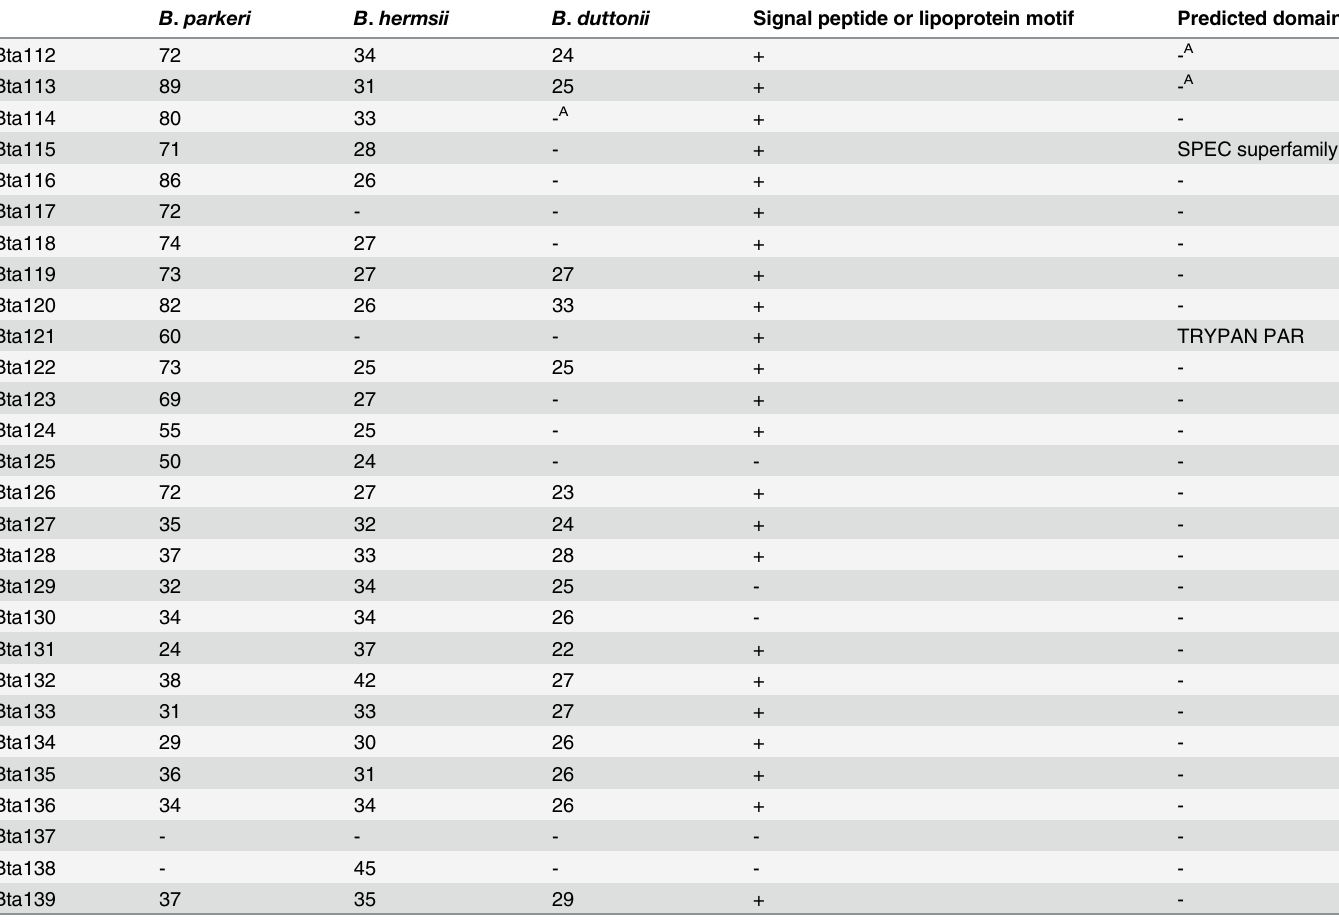
Table 1. Percent amino acid identity between B . turicatae Bta proteins located on the 3 ’ end of lp150 to B . parkeri , B . hermsii and B . duttonii